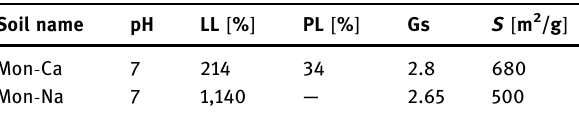
Table 3: Basic properties for Mon - Ca and Mon - Na used in veri fi ca - tion ( Mesri and Olson [ 36 ])